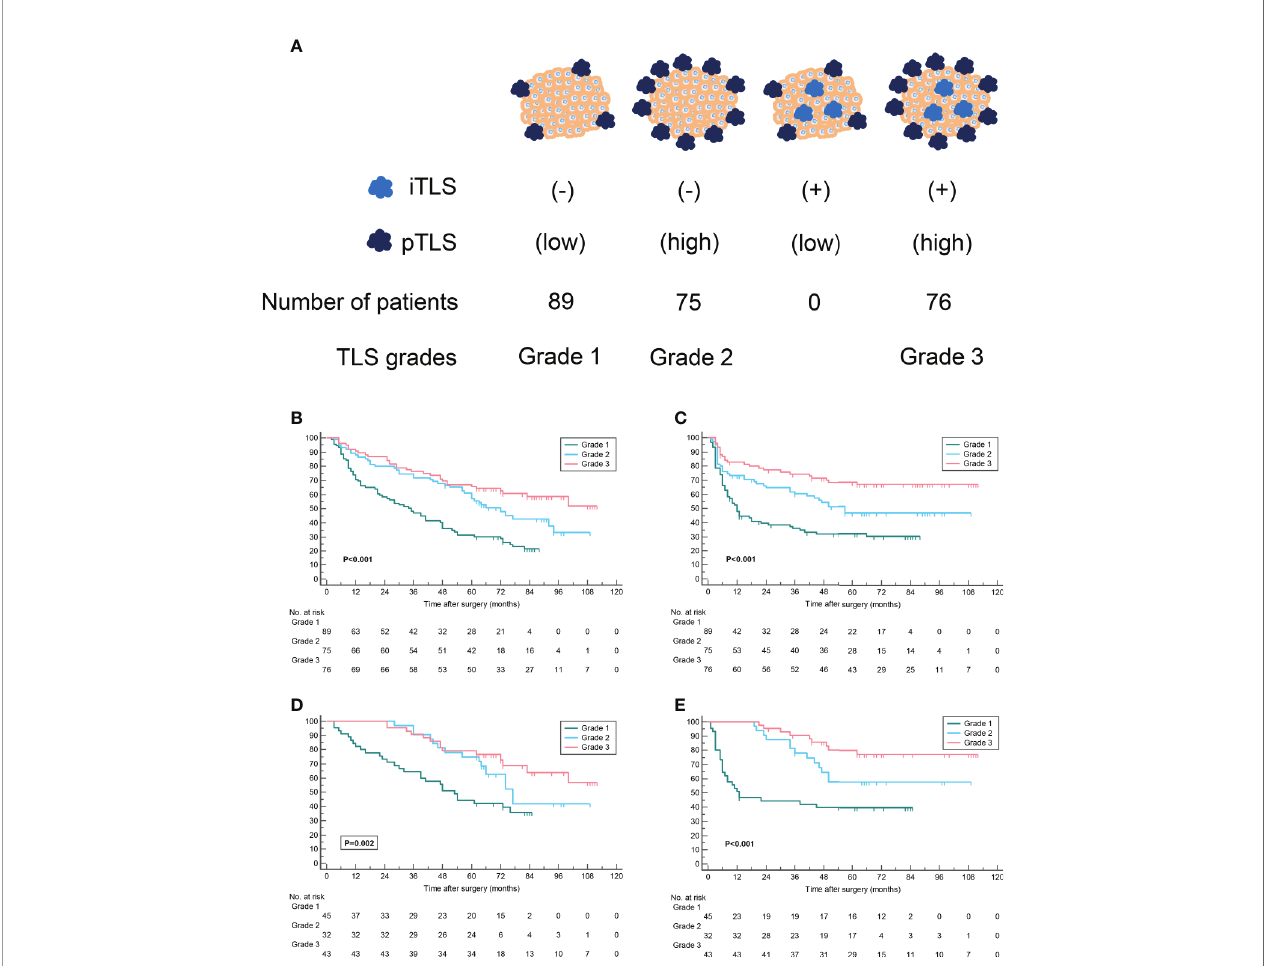
FIGURE 3 | TLS grades correlate with patient survival outcomes. (A) Tumors were strati fi ed according to the presence of iTLS and density of pTLS. Given no patient was associated with low pTLS density and presence of iTLS simultaneously, tumors were strati fi ed into three grades. (B – E) Kaplan-Meier curves were used for comparison of OS and RFS among patients strati fi ed by TLS grades in training cohort (B, C) and validation cohort (D, E) . Signi fi cance was tested by log-rank test. iTLS, intratumoral tertiary lymphoid structure; pTLS, peritumoral tertiary lymphoid structure; OS, overall survival; RFS, recurrence-free